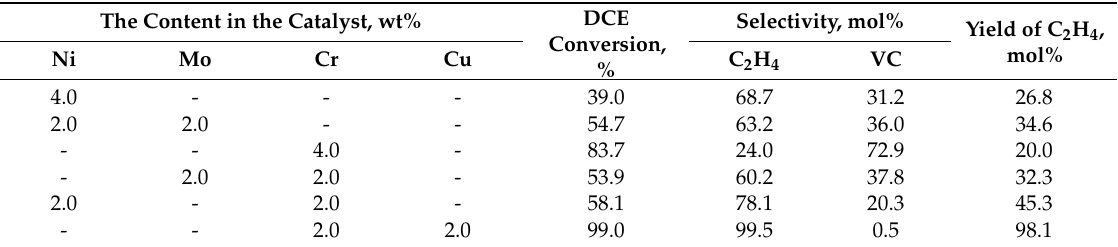
Table 11. Results of 1,2-dichloroethane hydrodechlorination on binary systems using nickel and